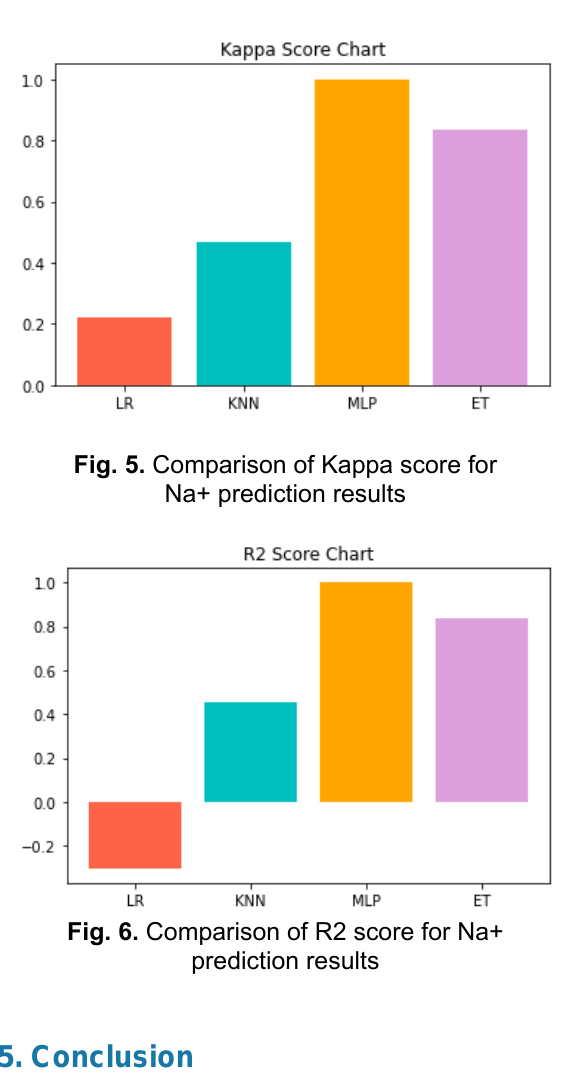
Fig. 6. Comparison of R2 score for Na+ prediction